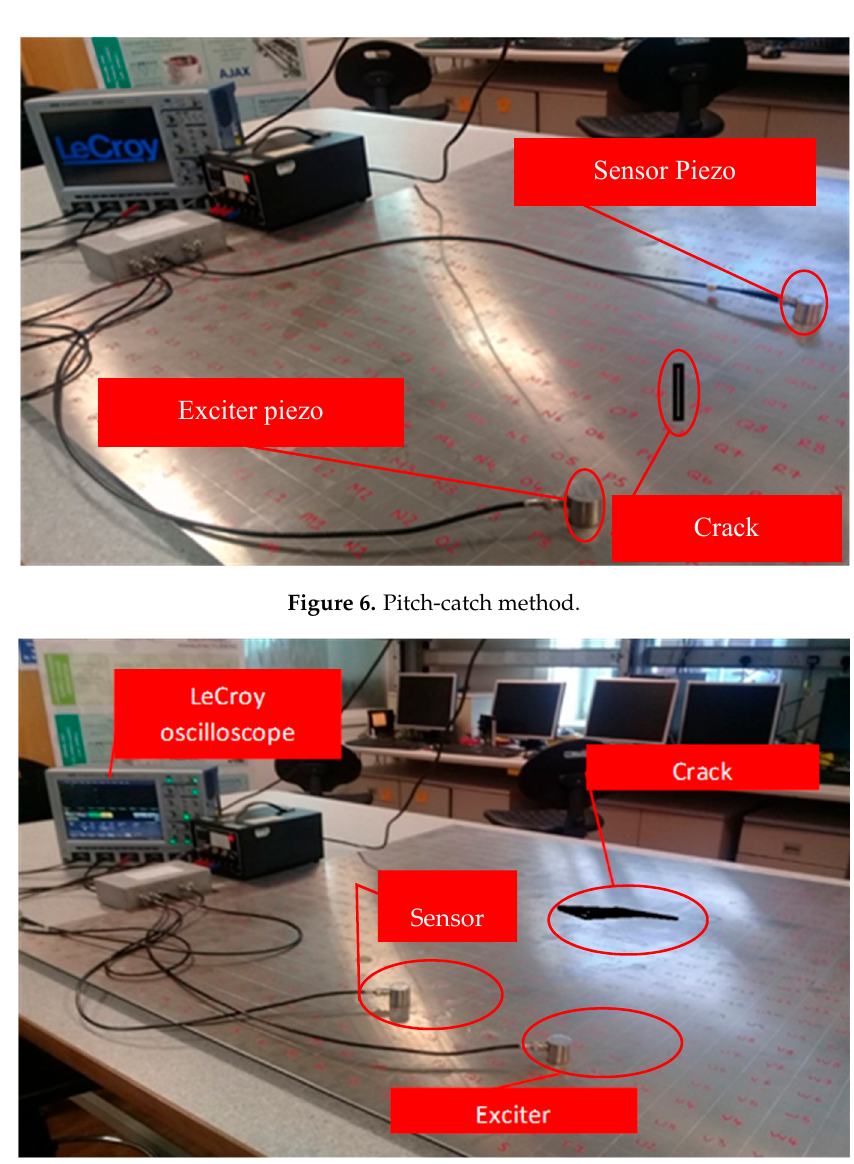
Figure 7 . Pulse-echo method. Figure 7. Pulse-echo